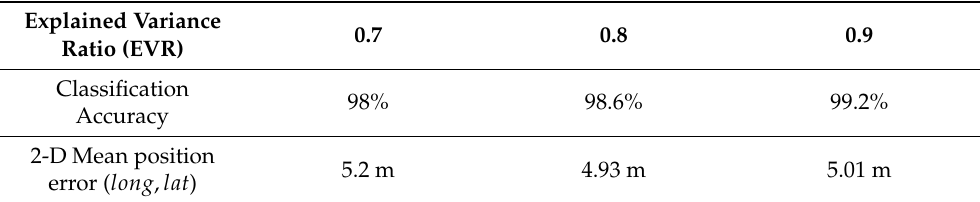
Table 5. Effect of explained variance ratio (EVR) on localization performance with different input and output